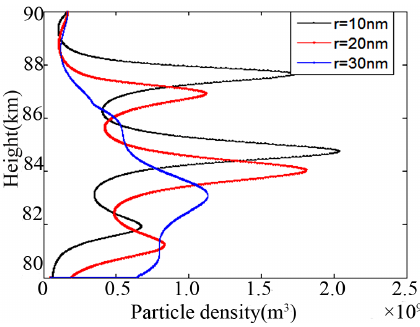
Figure 3. The formation of layered structures with different ice par- ticle sizes Radius r d = 10, 20, 30nm.